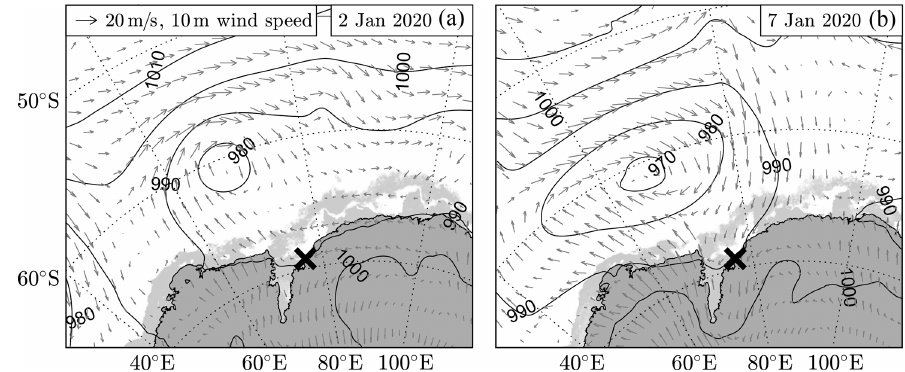
Figure 2. Passage of two storms offshore of the Antarctic instrument site on (a) 2 January 2020 and (b) 7 January 2020. Contours show mean sea level pressure, and wind speed at 10m is displayed through the vector field (both from ERA5). Light grey shading represents sea ice, derived from AMSR2 data (Spreen et al., 2008). The black cross identifies the deployment site. The presence of relatively high wind speeds over the polynya region on 7 January 2020 is expected to have generated wind waves at the deployment